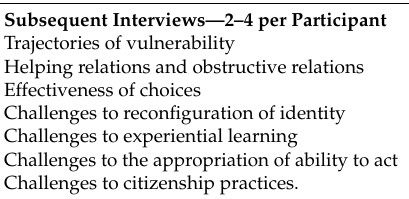
Table 1. Formal interview guide.